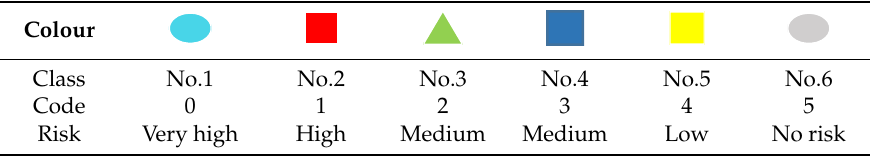
Table 4. Classes, symbols, and risk levels for reinforced concrete structures.